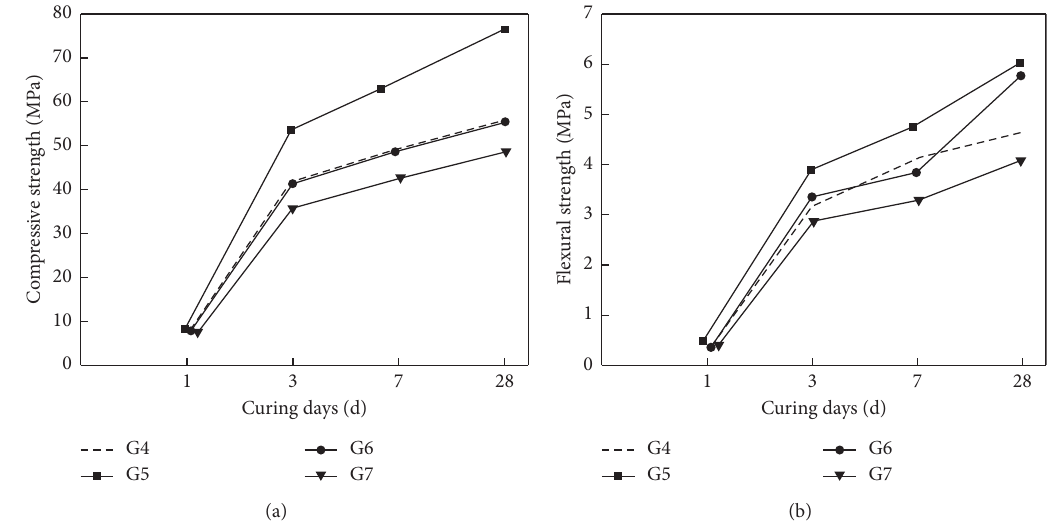
Figure 3: Effect of curing time on compressive strength and flexural strength of coal gangue-based geopolymeric concrete. (a) Effects on compressive strength. (b) Effects on flexural strength.